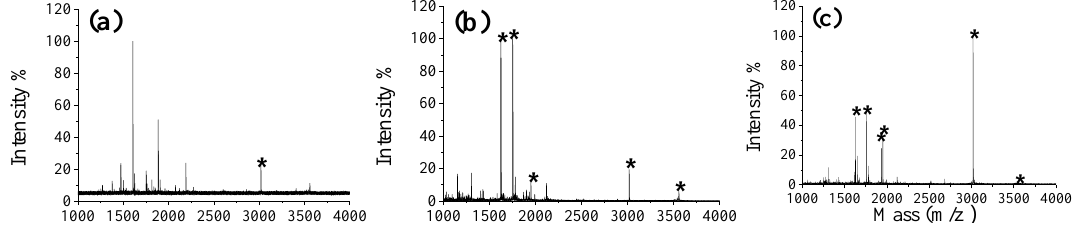
Figure 8. MALDI-TOF mass spectra of the tryptic digest mixture of ASF (asialofetuin) and MYO (myoglobin), the mole ratio of ASF:MYO = 1:10. ( a ) direct analysis; ( b ) analysis after enrichment by MSP@NAMAm-1 and deglycosylation by PNGase F; ( c ) analysis after enrichment by MSP@NAMAm-4